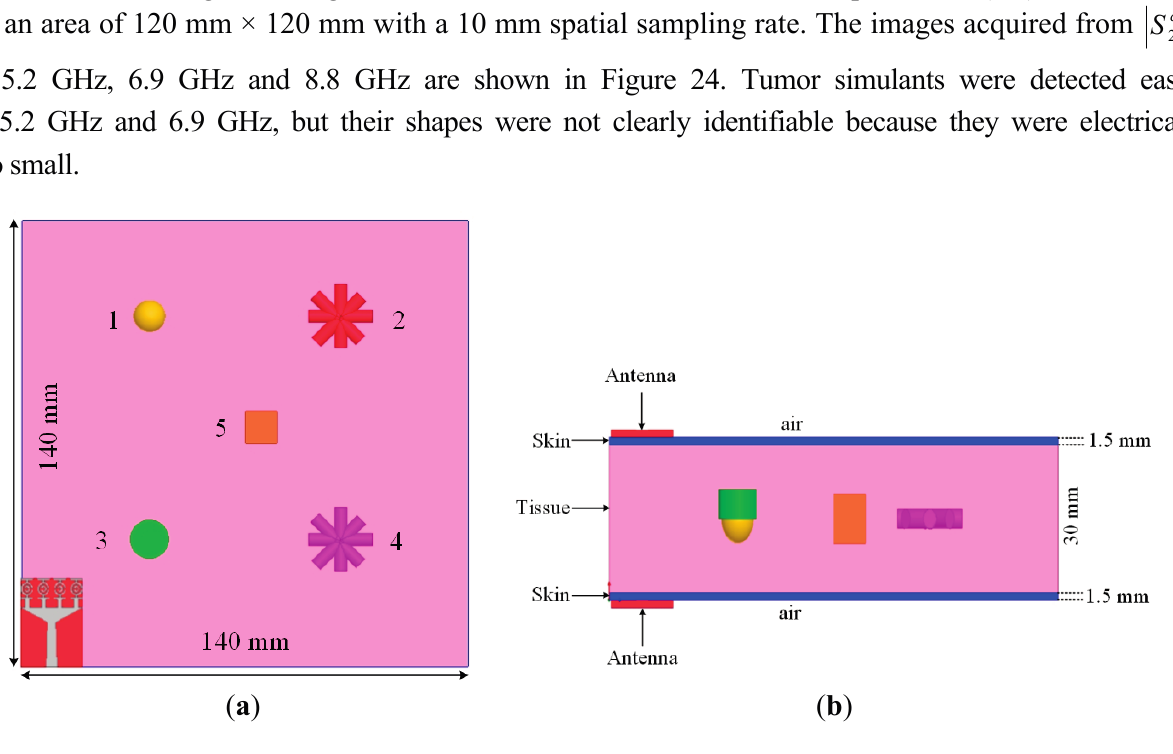
Figure 23. The breast phantom with tumour simulants ( a ) Top view; ( b ) Cross view including two proposed UWB